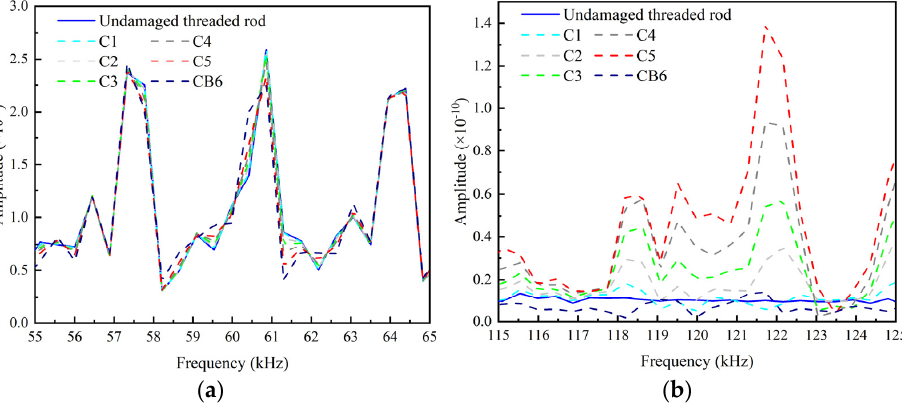
Figure 17. Spectrum at central exciting frequency of 60 kHz. ( a ) Main frequency spectrum. ( b ) Second-order frequency spectrum.